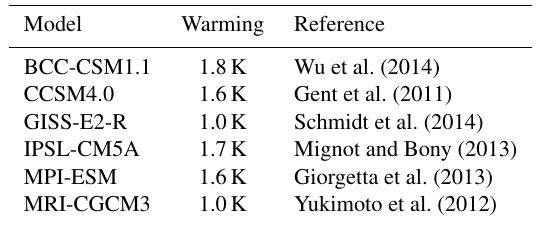
Table 3. Summary of models used to calculate the multi-model mean surface temperature anomaly from the PMIP3-CMIP5 sim-